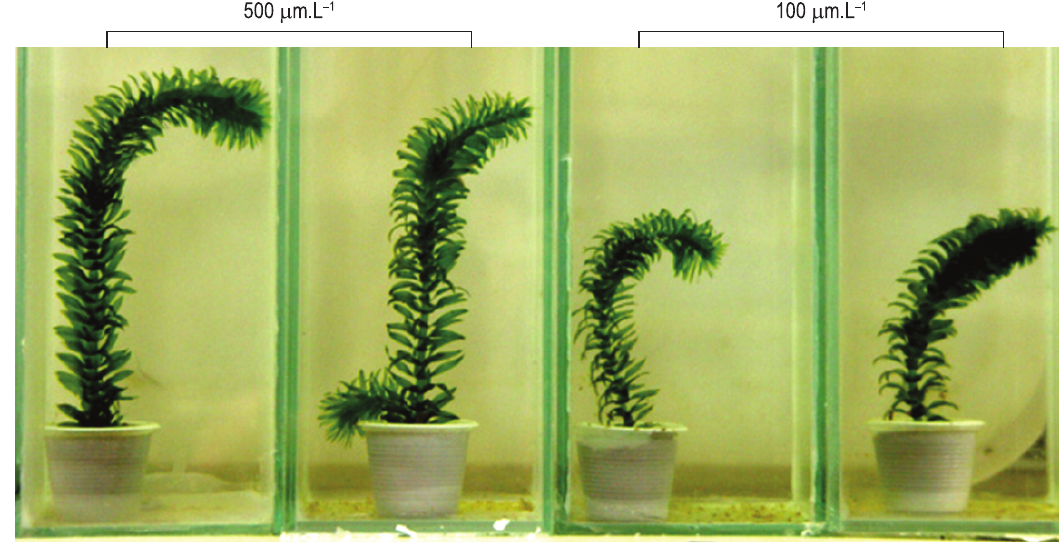
Figure 2. Picture of E. densa , after 21 days growing in two alkalinity